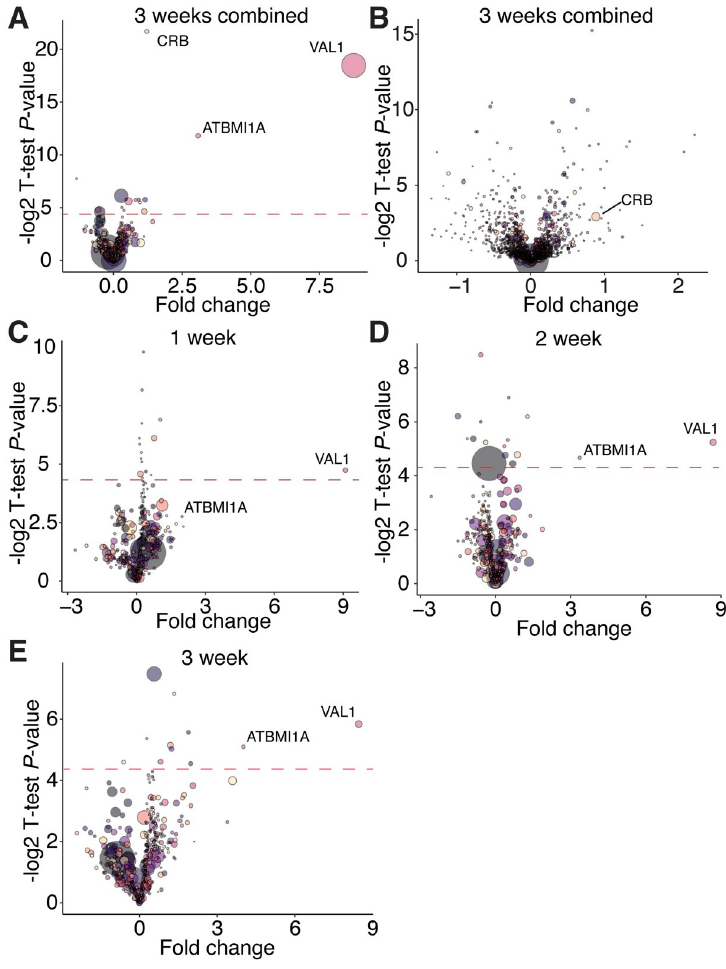
Fig 7. VAL1-protein interactions are consistent during vegetative development. (A-E) Protein enrichment calculated via mass spectrometry. Fold change represents the ratio of proteins purified from experimental ( VAL1-HA; val1-2; FRI-Sf2 ) to control ( val1-2; fri ) samples, a t-test P -value is represented on the y-axis. Red dotted line indicates a P- value < 0.05 (resulting from the -log2 transformation of the actual p-value; proteins above the line have a significant enrichment). Each bubble represents an individual protein, the size or the bubble represents the protein abundance averaged across the experimental and control samples. (A, C-E) Proteins immunoprecipitated using an anti-HA antibody, (B) total proteome samples. samples (Fig 7B). Comparisons of the proteins present in samples harvested from 1, 2 and 3 weeks old plants revealed that ATBMI1A was consistently among the most abundant proteins immunoprecipitated with VAL1-HA (Fig 7C, 7D and 7E). The abundance of ATBMI1A in the immunoprecipitated sample increased significantly from 1 week to 2 weeks, as indicated by both the increase in the fold change between experimental and control samples, and the statis- tical significance of the enrichment. This is probably a result of the increase in the abundance of VAL1 between 1 and 2 weeks (Fig 6D and 6E), a result which was confirmed by the increas- ing abundance of VAL1 in the immunoprecipitated samples from different time points (Fig 7C, 7D and 7E). The parallel changes in the abundance of VAL1-HA and ATBMI1A, and the absence of any major change in the proteins associated with VAL1-HA in different samples, suggest that the binding partners of VAL1 do not change significantly during shoot development.